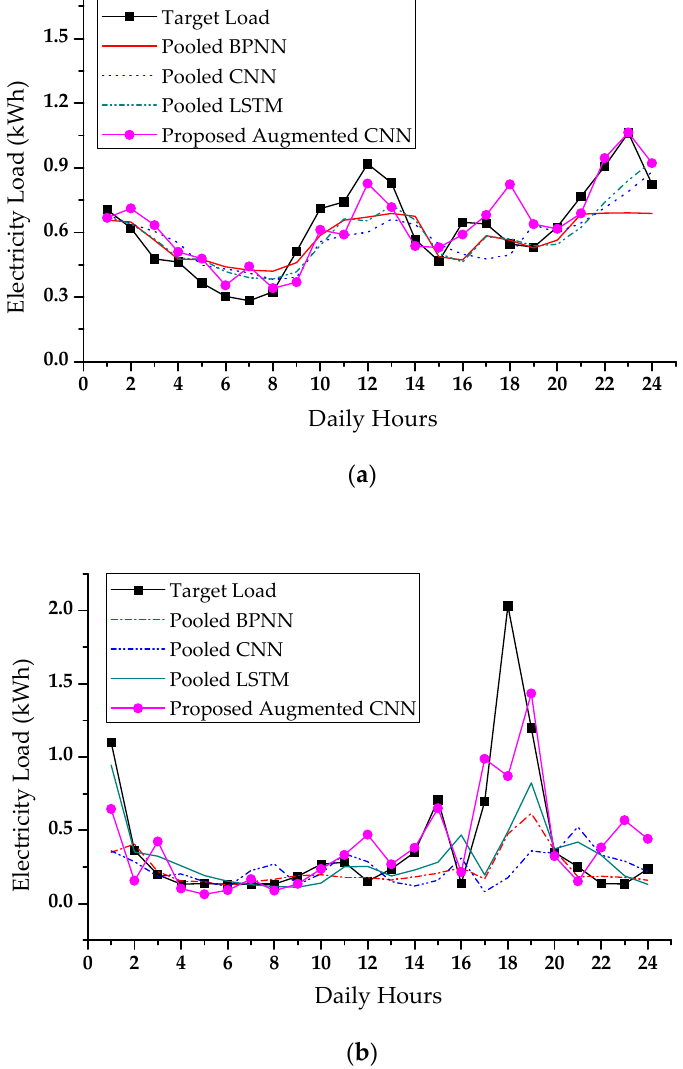
Figure 10. Day-ahead load forecasting for peak day: ( a ) lower uncertain household (household 4) and ( b ) higher uncertain household (household 10).